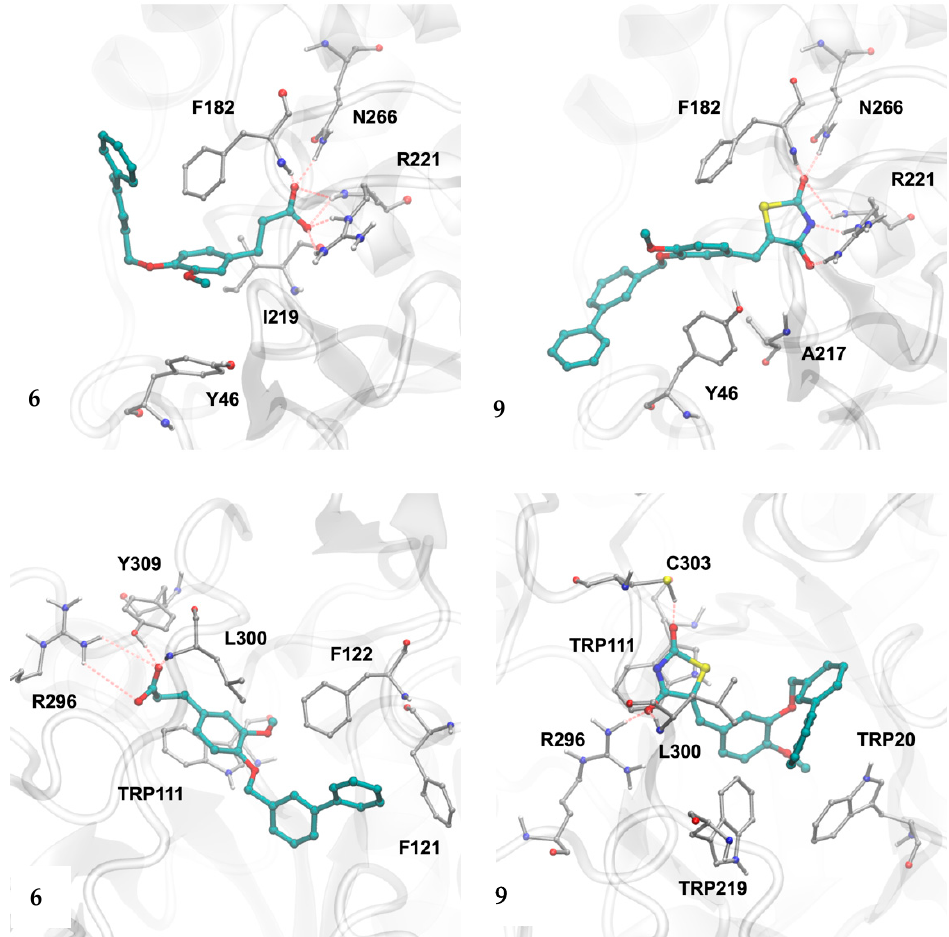
Figure 6. Most populated cluster for the simulations between Compounds 6 and 9 with PTP-1B ( top ) and AR ( bottom ) during the 300 ns of simulation. Hydrogen-bond interactions are indicated with dashed